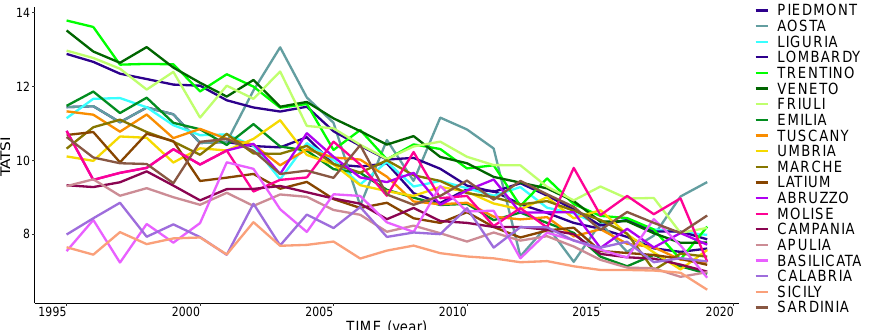
Figure A5. TATSI index for the Italian population aged 65 from 1995 to 2019 across regions (NUTS-2 level). Source: author’s own elaboration on data from